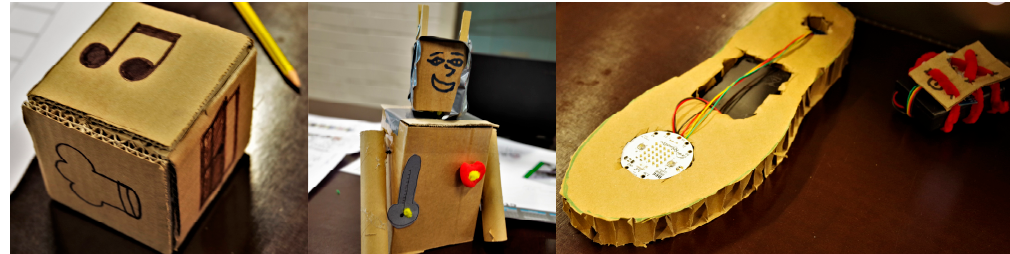
Figure 6. Cardboard prototypes of DUC ( left ) and Bobby ( centre ); Hardware prototype of FitFoot ( right ).